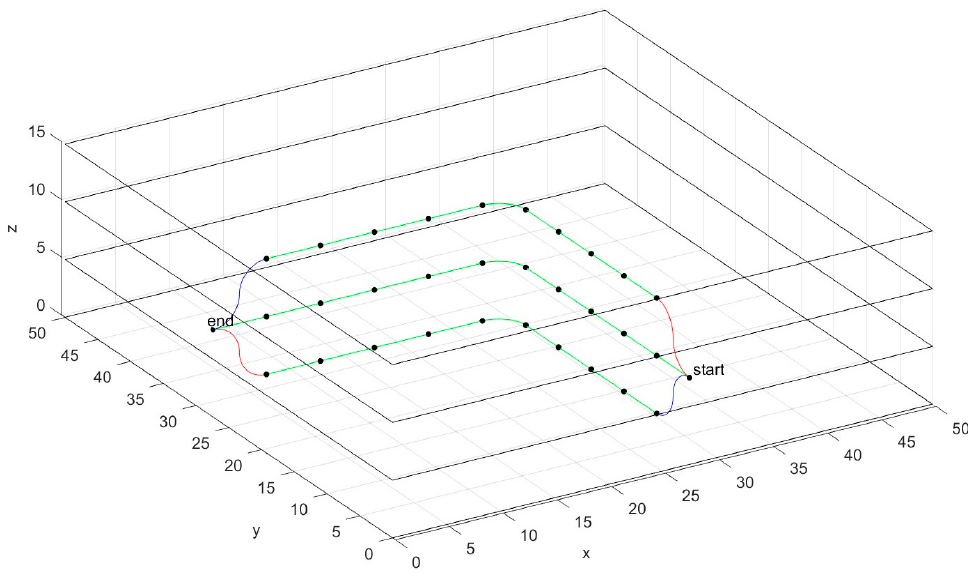
Figure 10. 3D view of the graph to be searched for a UAV entering from the left-most entrance on mode 2 where UAV can change layer only at the start and end of the intersection.